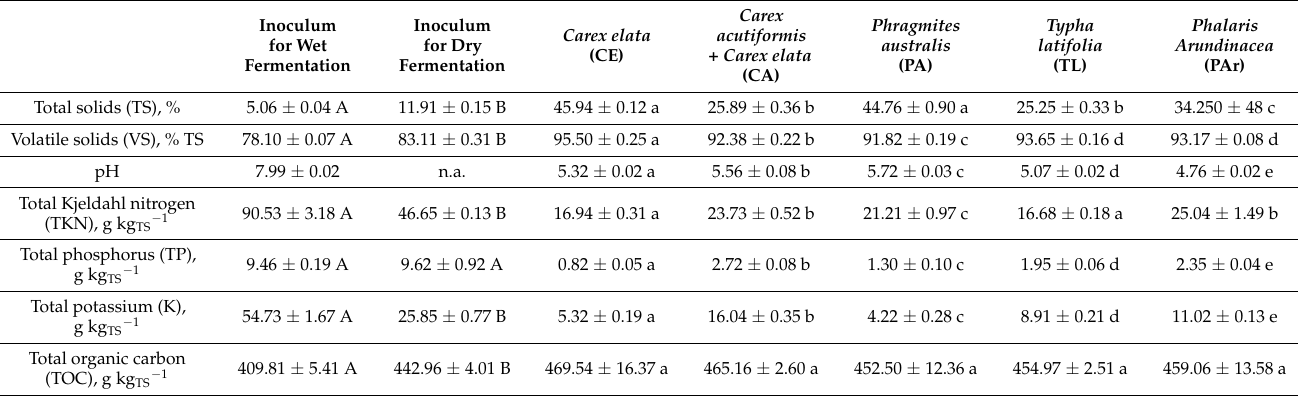
Table 1. Chemical composition of the inocula for the dry and wet fermentation experiment and wetland plant silage. Inoculum Inoculum for Wet for Dry Fermentation